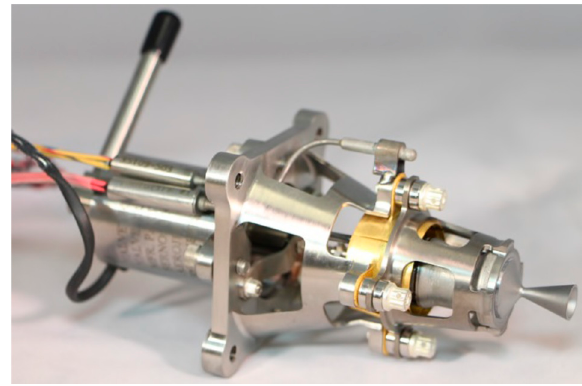
Figure 11. GR1 Thruster [32].